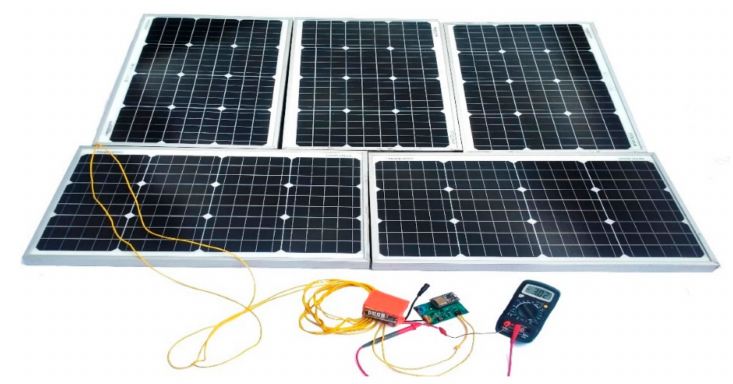
Figure 6. Normal operation of five active PV modules.